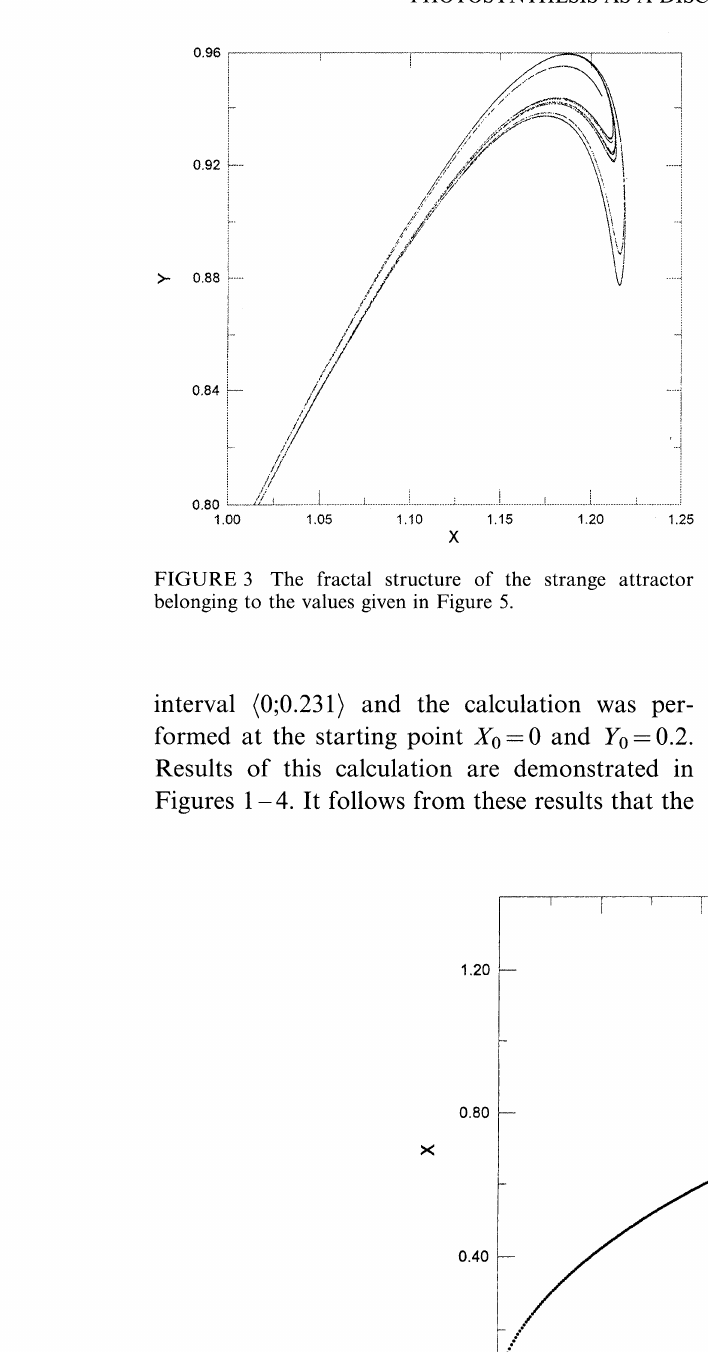
FIGURE 4 The bifurcation diagram of a photosynthetic system described by logistic